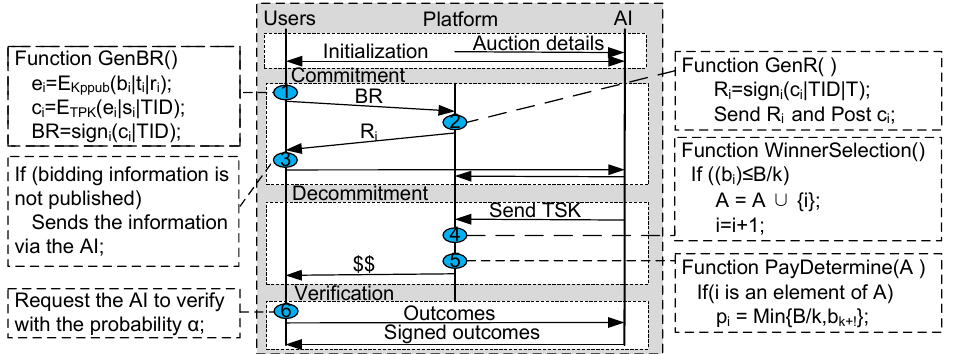
Figure 2. Our privacy-preserving verifiable framework for homogeneous and heterogeneous